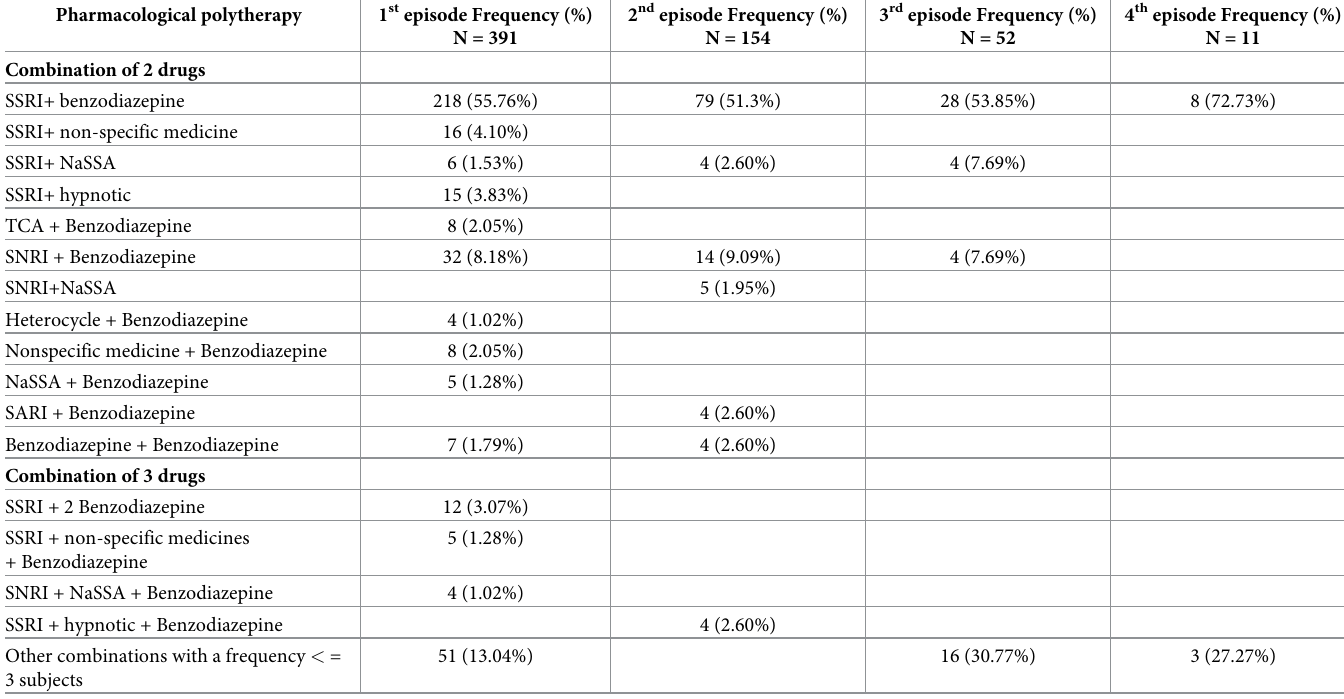
Table 5. Description (frequency and percentage) of combined pharmacologic treatment (ATC classification) for each depressive episode. Pharmacological polytherapy